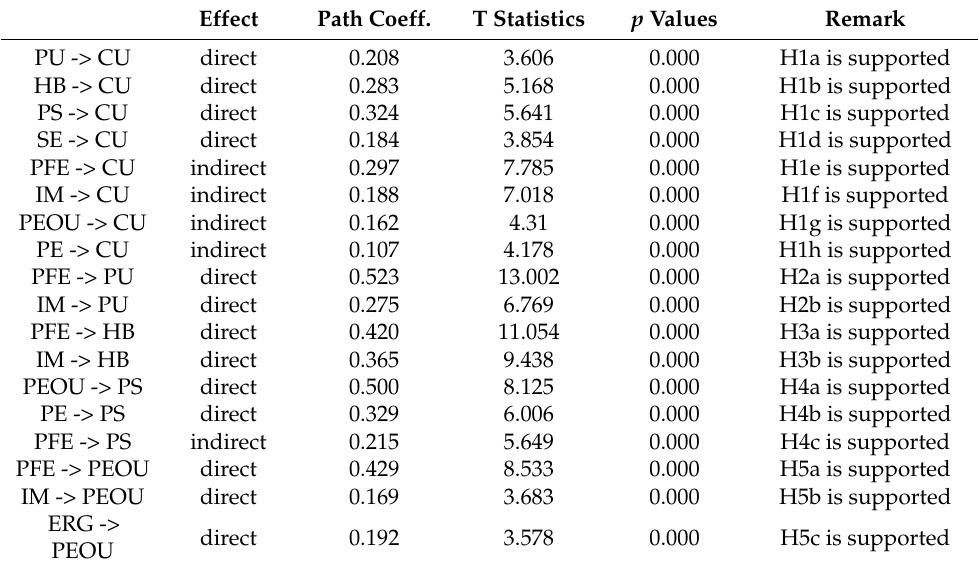
Table 5. Path coefficients.